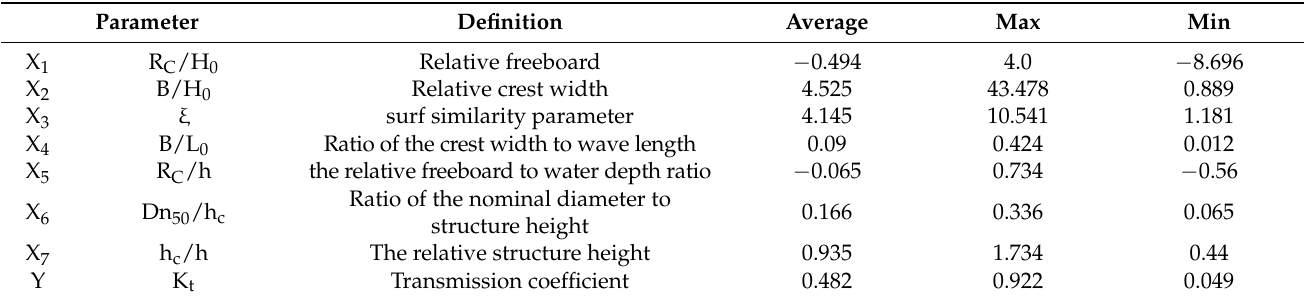
Table 1. Definitions and ranges of scaled model parameter.